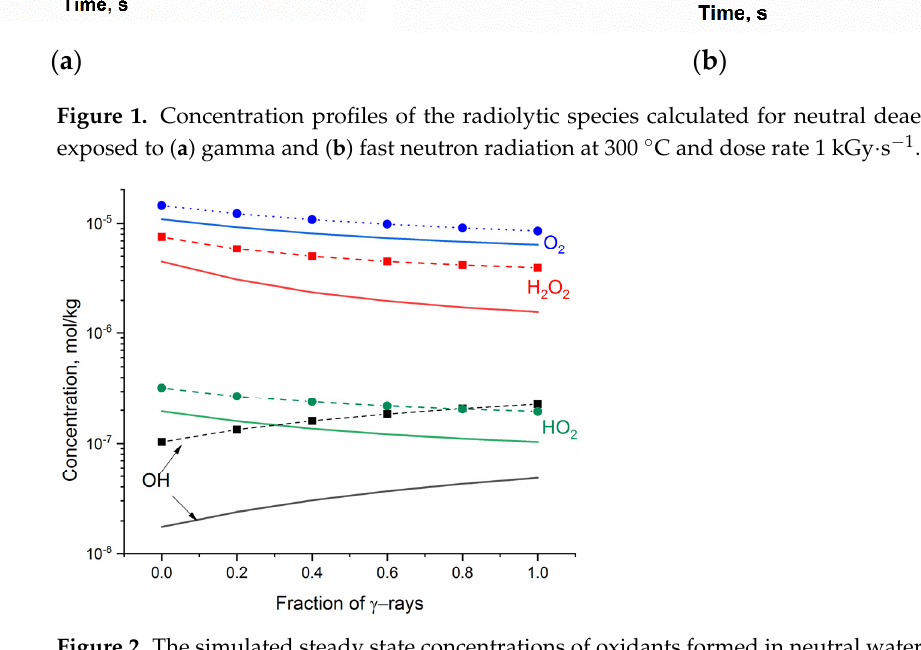
Figure 2. The simulated steady state concentrations of oxidants formed in neutral water vs. fraction of γ -rays ( f g ) in the mixed gamma-fast neutron radiation: solid lines indicate dose rate of 1 kGy·s − 1 ; dashed + symbol indicates 10 kGy·s − 1 .